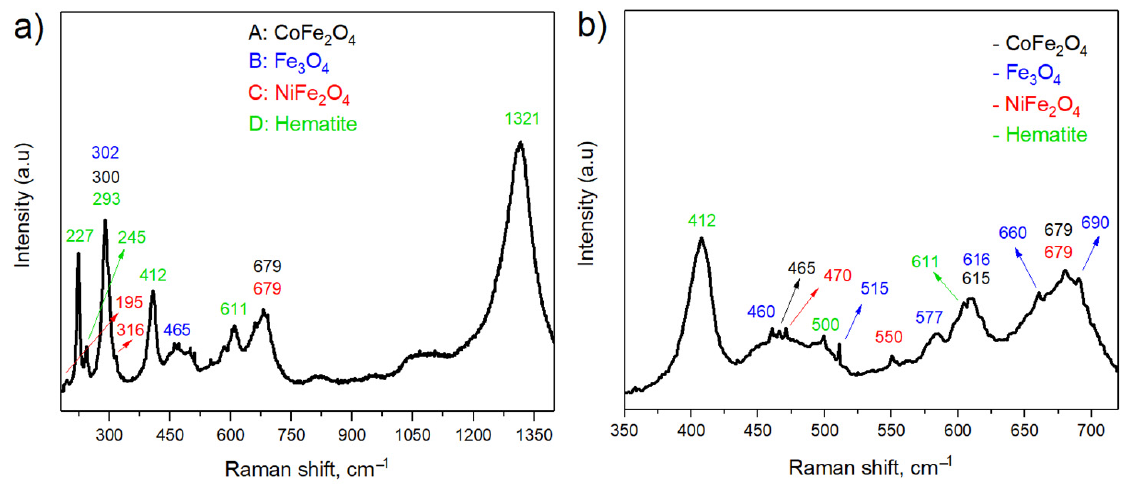
Figure 8. Raman spectrum collected from the oxide layer produced on maraging 300 alloy, showing the main compound peaks. ( a ) General view and ( b ) a high magnification ranged between 350 and 715 cm − 1 .